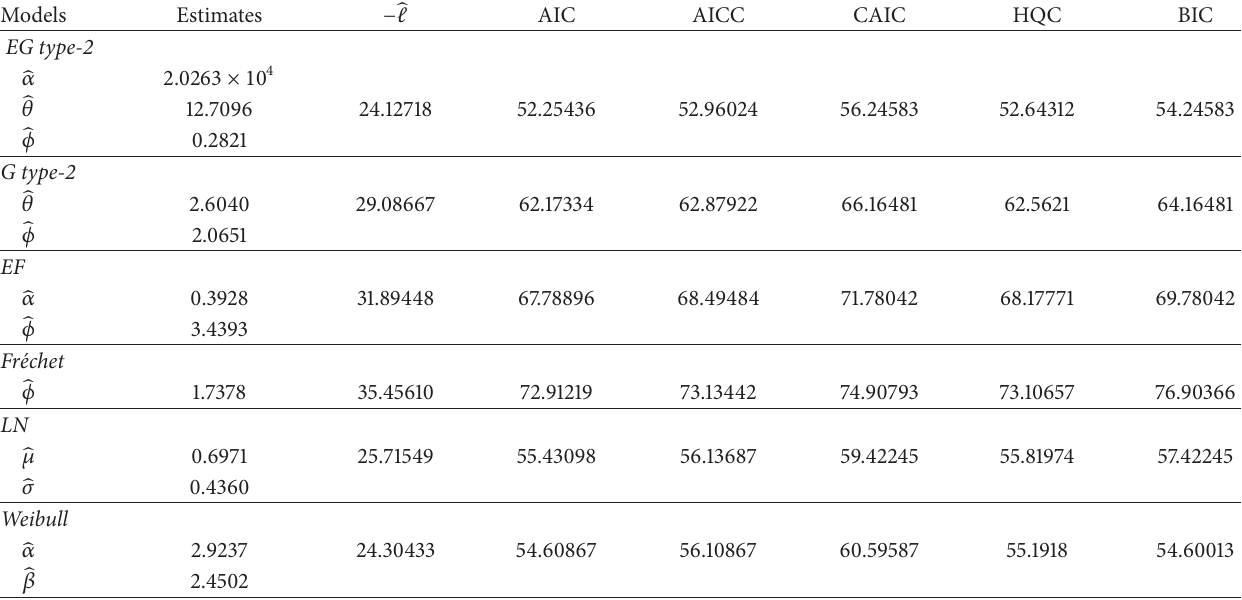
Table 2: Results from the survival times data fitting.